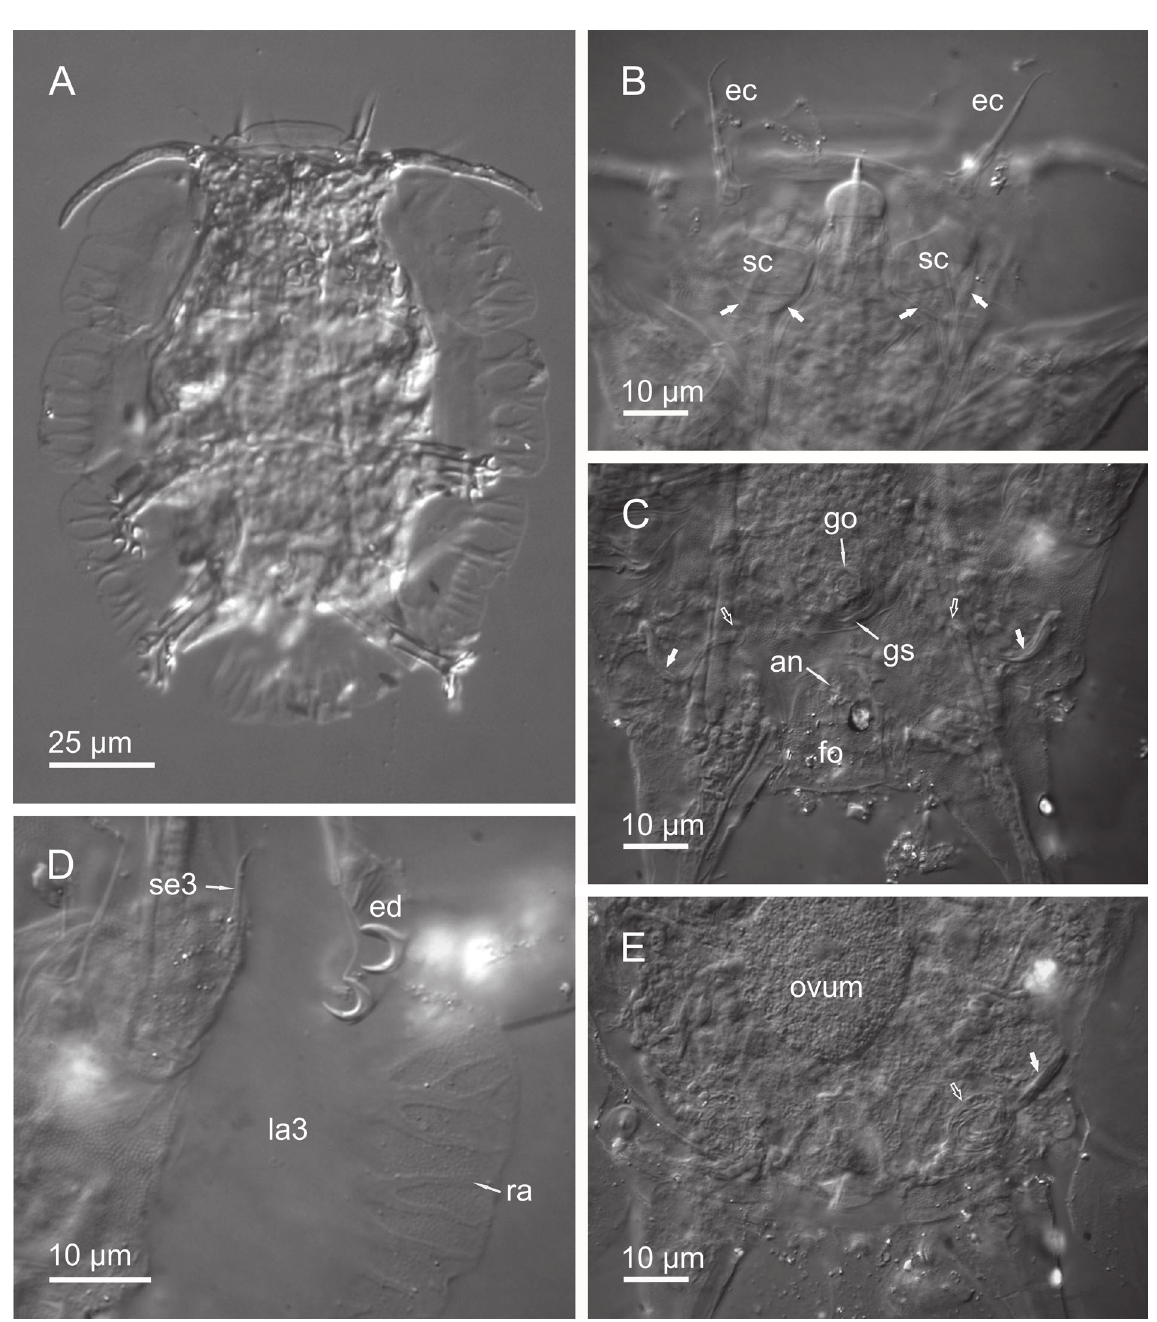
Fig. 3. DIC-micrographs of Higginsarctus signeae gen. et sp. nov. A . Paratype, ♀ (NHMD-293898), overview. B–E . Holotype, ♀ (NHMD-293899). B . Close up on the head, ventral view showing the secondary clavae and the very refractive cupola of the mouth cone. White solid arrows indicate elevation of the cuticle associated with the secondary clavae. C, E . Optical sections of the caudal end, showing gonopore, genital stoup, duct openings (white hollow arrows), ducts of the seminal receptacles (white solid arrows) and the ventral folium with anus (C), and ovum, duct of the seminal receptacles (white solid arrow) and vesicle of seminal receptacles (white hollow arrow) (E). D . Close up on the procuticular branches (ramuli) in the ala, the internal and external claw of leg II and the sense organ of leg III. Abbreviations: see Material and